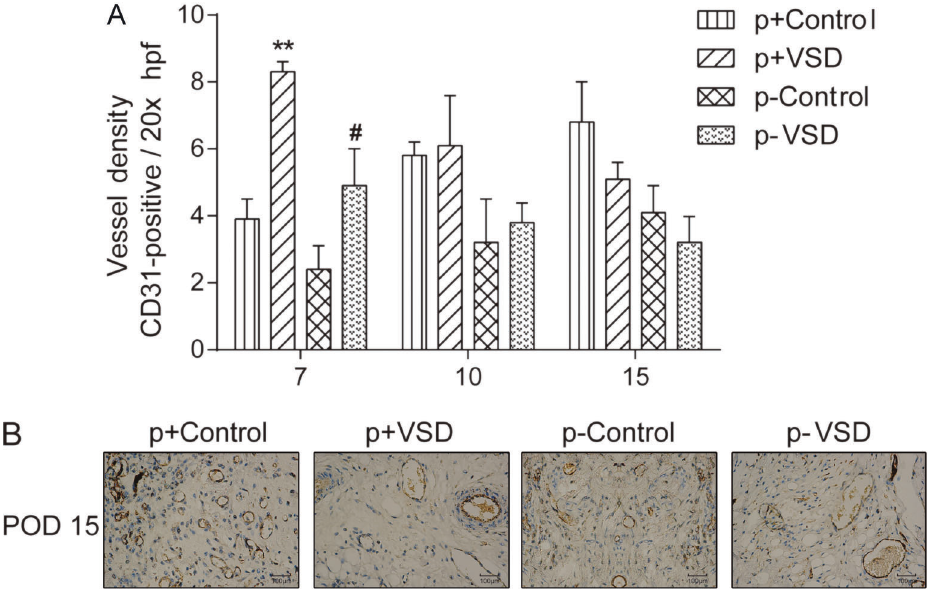
Figure 4. A , Microvessel density in tissues during the course of wound healing (post-operative days (POD) 7, 10, and 15). B , Vacuum sealing drainage (VSD)-treated wounds had larger-caliber, and more well-developed vessels compared to the traditional dressing wounds (Control), by immunostaining of CD31 on POD 15 (magni fi cation 200 (cid:1) ). Data are reported as means ± SD. **P o 0.01 compared to p + Control, # P o 0.05 compared to p – Control. p + : periosteum-intact; p – : periosteum-lacking.